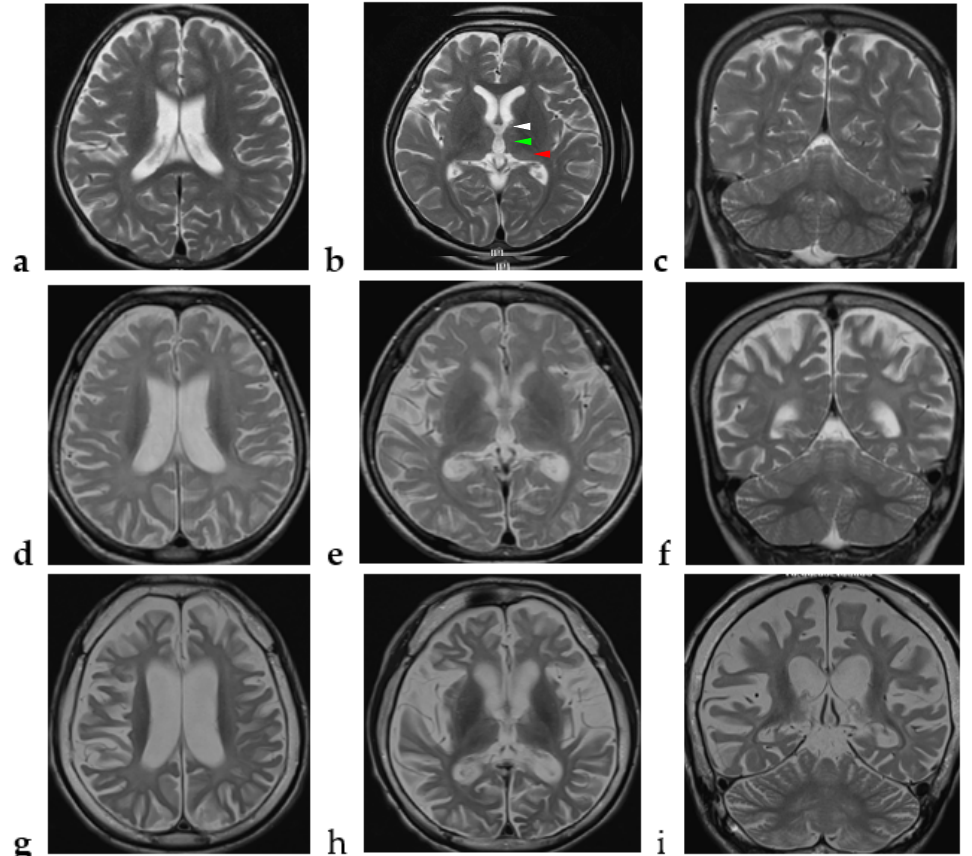
Figure 1. Chronological changes of the brain MRI in the index case. ( a – c ) At the age of 4 years and 8 months, axial view (TE 106 ms/ TR 6300 ms) and coronal view (TE 105 ms/ TR 5433 ms) of brain MRI show high signal intensity over the bilateral anterior (white arrow head), dorsomedial (green arrow head), and pulvinar (red arrow head) nuclei of the thalamus and the bilateral periventricular and peritrigonal white matter and generalized cortical atrophy. ( d – f ) At the age of 7 years and 2 months, axial view (TE 84 ms/ TR 4500 ms) and coronal view (TE 91 ms/ TR 4500 ms) of brain MRI show extensive high signal intensity over the bilateral thalamus; diffuse, symmetric, and obvious high signal intensity over the bilateral periventricular and peritrigonal white matter; and progressive cortical and subcortical supratentorial atrophy. ( g – i ) At the age of 13 years and 11 months, axial view (TE 102 ms/ TR 3430 ms) and coronal view (TE 83 ms/ TR 3530 ms) of brain MRI show progressive changes over the whole thalamus and the aforementioned areas and evident cerebellar atrophy with high signal intensity over the bilateral cerebellar white matter.